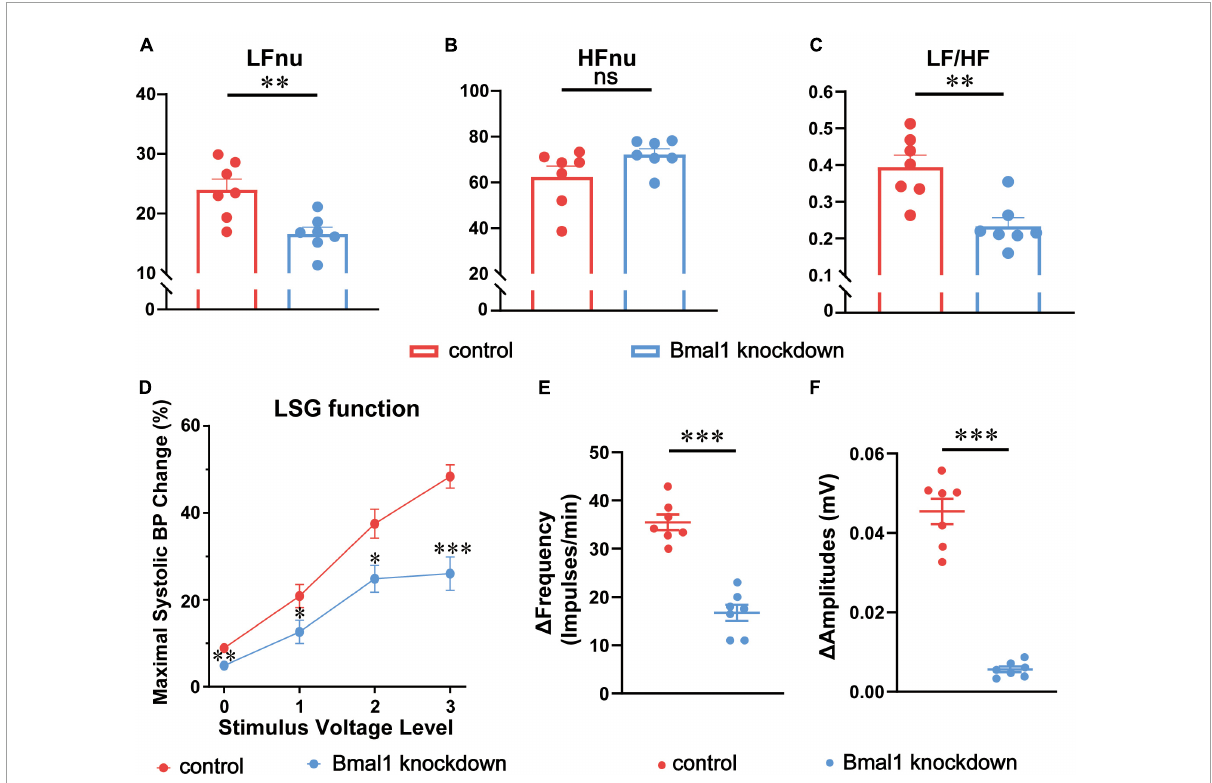
FIGURE3 Effects of Bmal1 knockdown on the sympathetic tone, LSG function, and neural activity. The HRV indicators recorded by the Power Lab System: (A) LFnu, (B) HFnu, (C) LF/HF. (D) Maximal systolic BP change (LSG function) at 4 voltage levels. Alteration in the (E) frequency and (F) amplitude of LSG neural firing (LSG neural activity) in the two groups after MI. n = 7 for each group. ∗ p < 0.05. ∗∗ p < 0.01. ∗∗∗ p < 0.001. LSG, left stellate ganglion; LFnu, normalized low-frequency power; HFnu, normalized high-frequency power; BP, blood